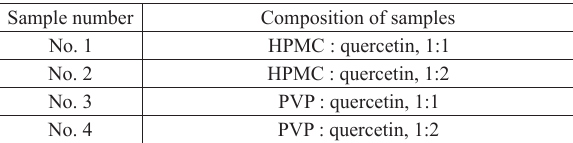
Composition of the investigated samples of solid dispersions of